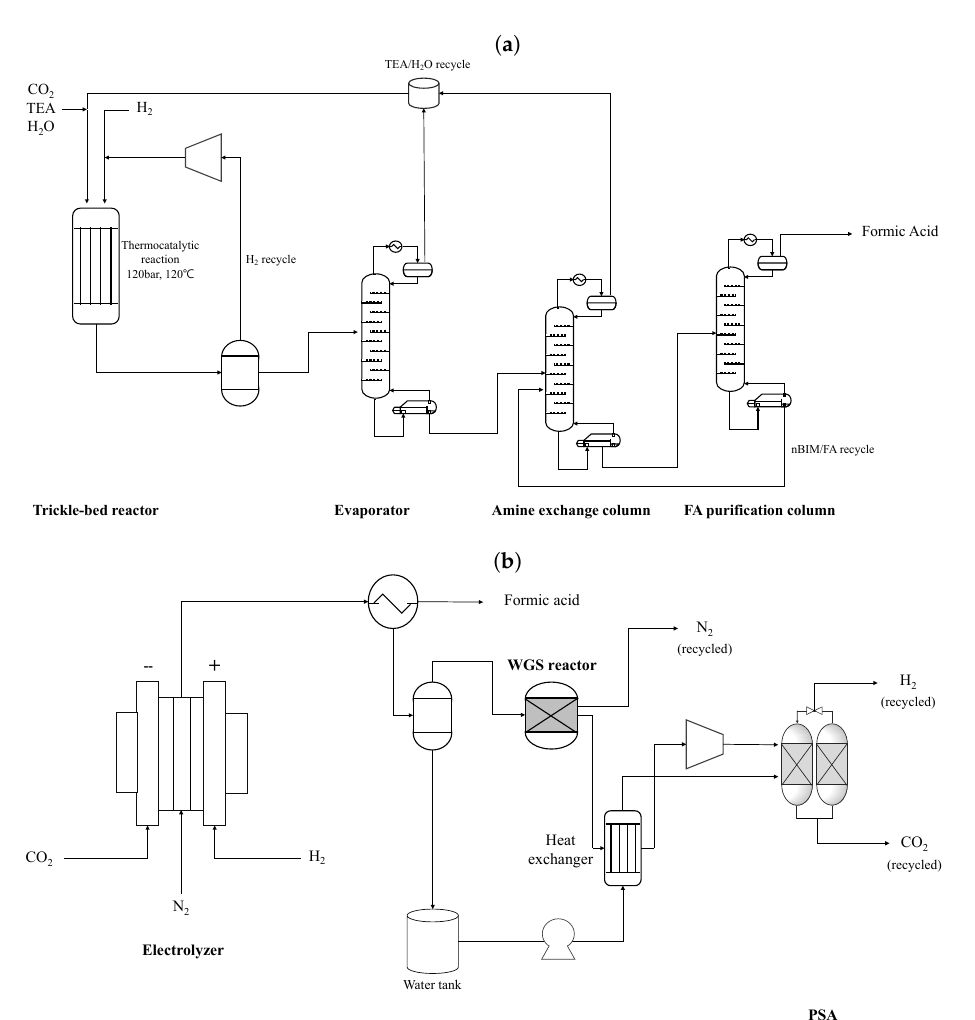
Figure 7. The tcFA and ecFA production pathways via CO 2 conversion. ( a ) Process flow diagram for thermocatalytic CO 2 hydrogenation to FA, and ( b ) process flow diagram for electrochemical reduction of CO 2 to